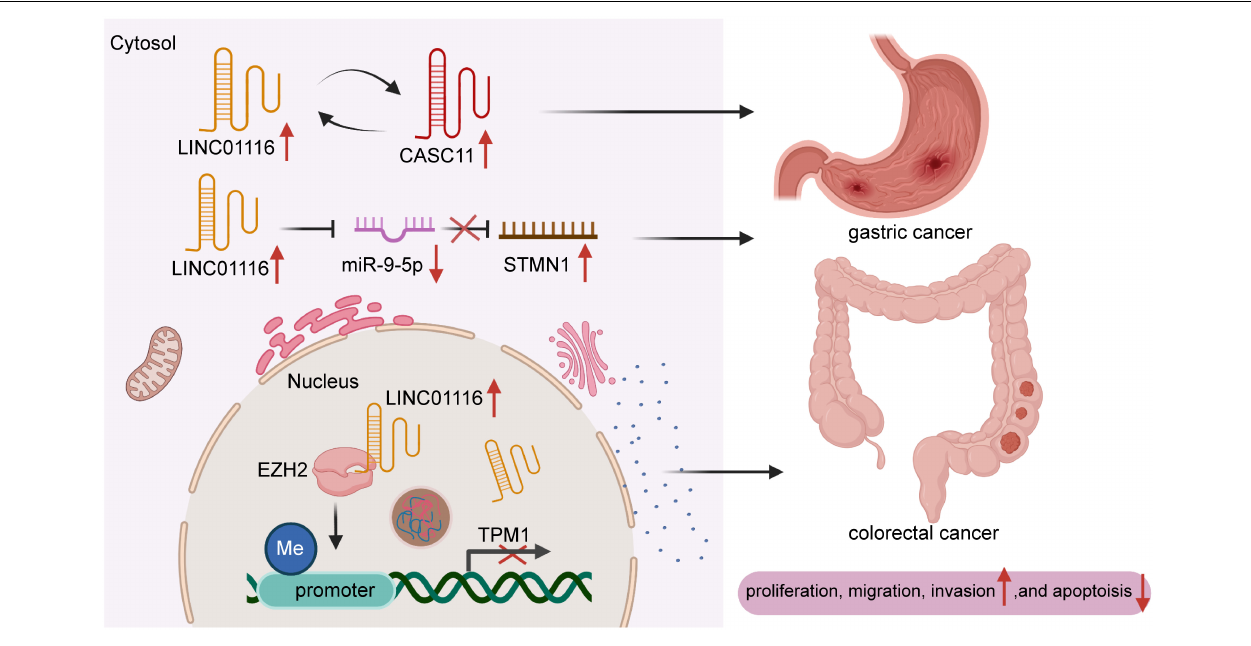
FIGURE 4 | The molecular mechanism map of LINC00261 in gastric cancer and colorectal